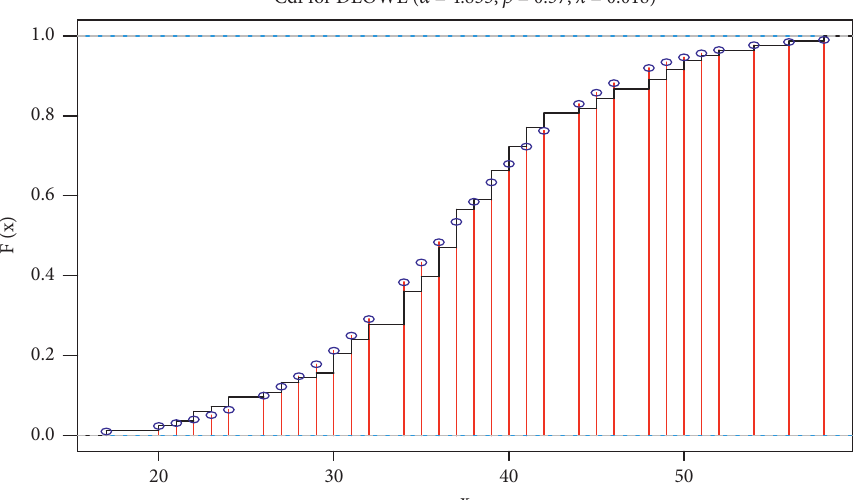
Figure 10: Graphical plots of the data and the CDF, as we can see in the plot, the distributions with the random variable with value x , where x is the number of deaths per